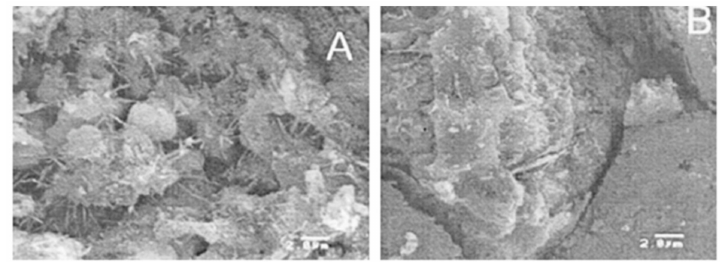
Figure 1. SEM micrographs of plain ( A ) and nano-silica modified cement paste ( B )